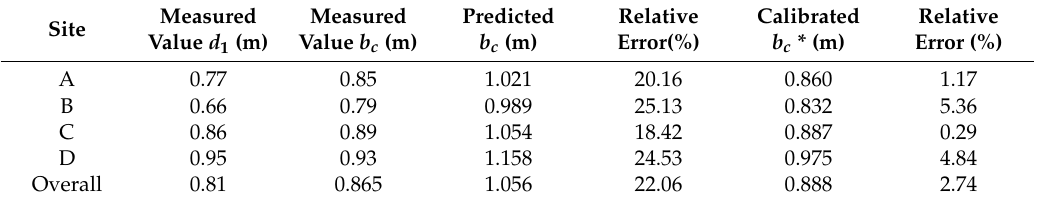
Table 5. Comparison of in situ measured and predicted width of the collapsed block at four